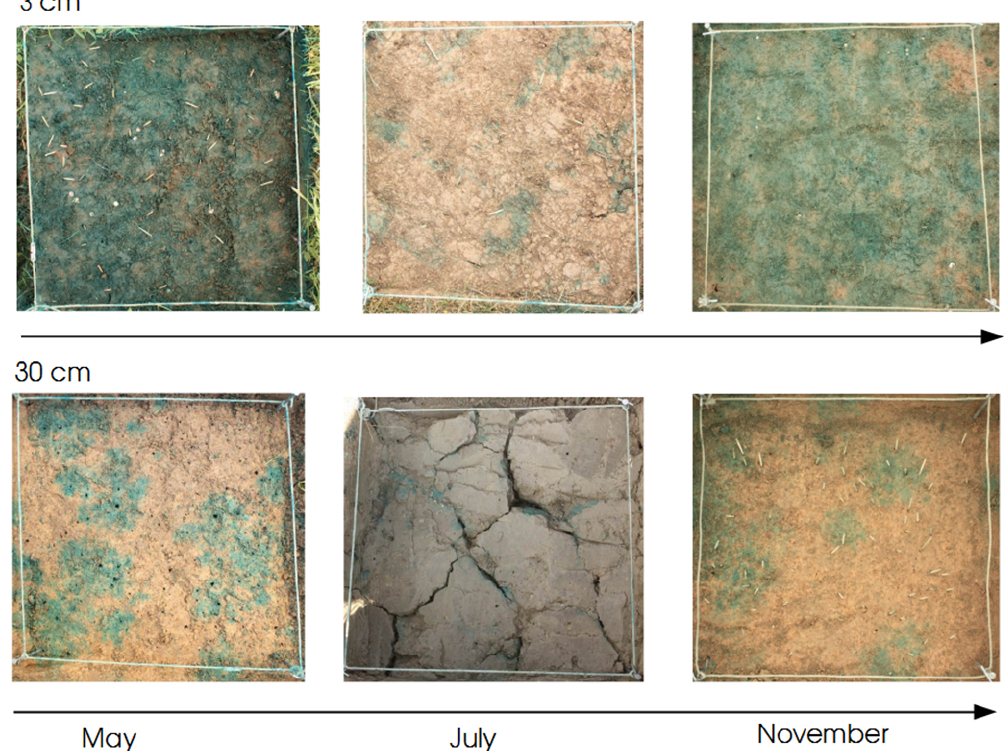
Figure 4. Emergent structures in the Wollefsbach catchment for the sampling dates (plot size is 1m 2 ). In May macropore flow through earthworm burrows dominates infiltration, while in July clearly visible soil cracks occur. In contrast, a more homogenous infiltration pattern is visible in November, especially at 3cm depth.